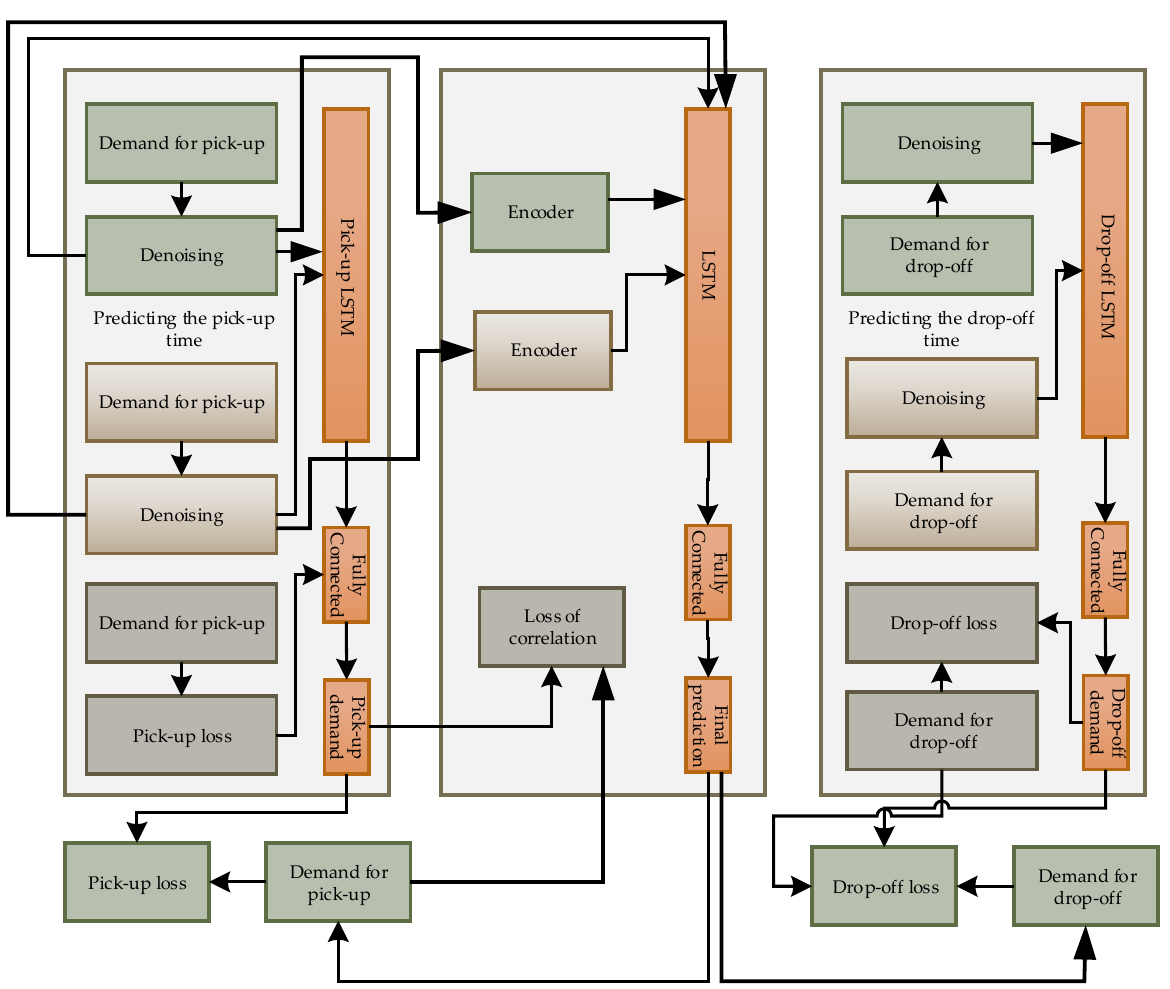
Figure 7. Multi-task learning-based on LSTM model for taxi demand pick-up and drop-off